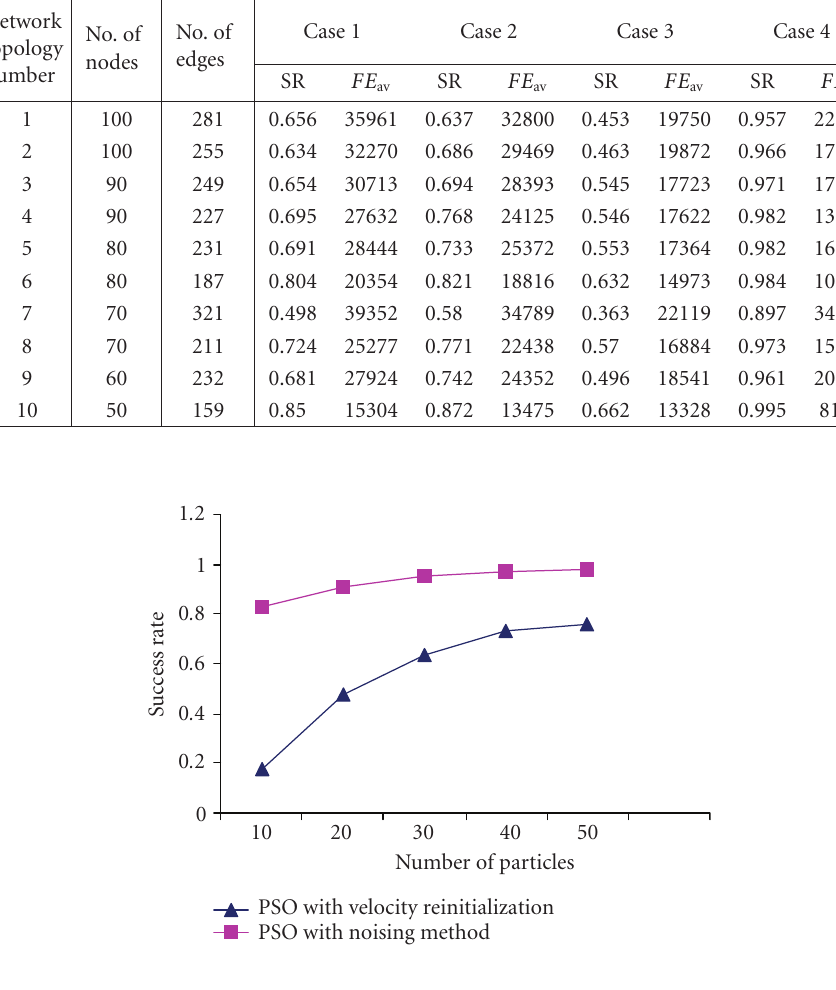
Figure 4.1 . Success rate versus number of particles for network number